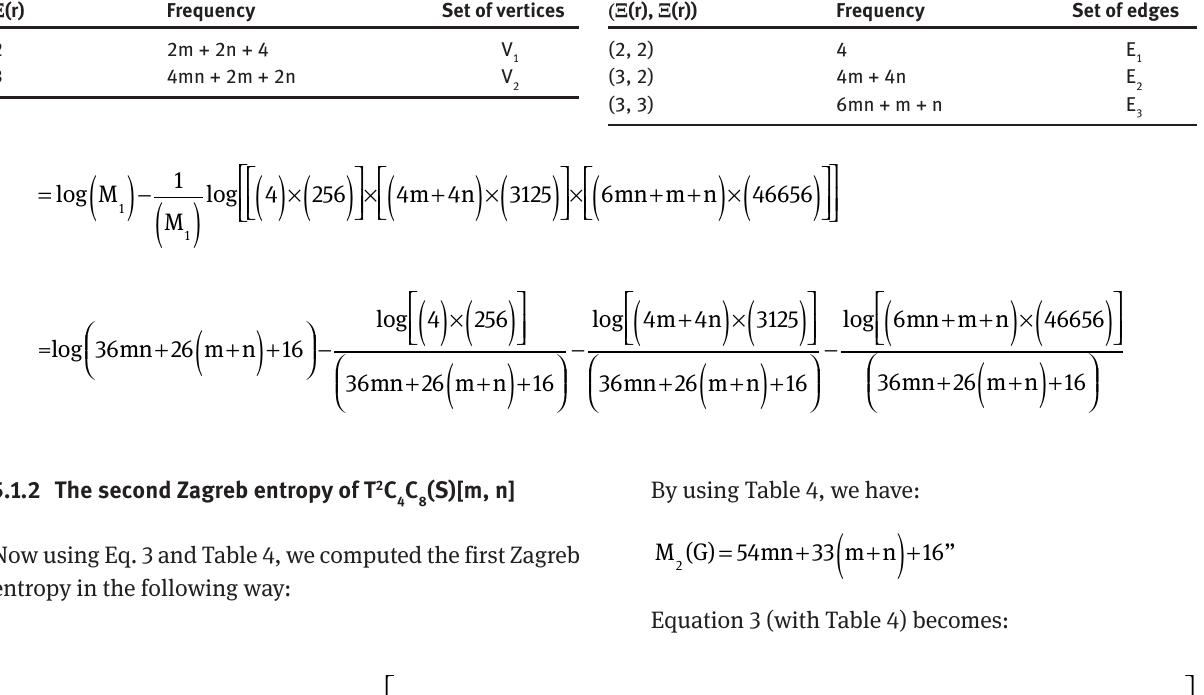
Table 3: Vertex partition of T 2 C